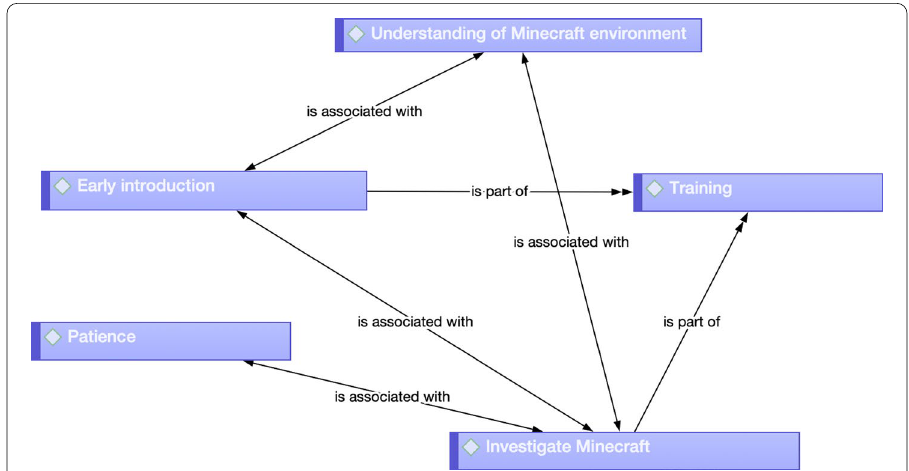
Fig. 4 Future lessons network